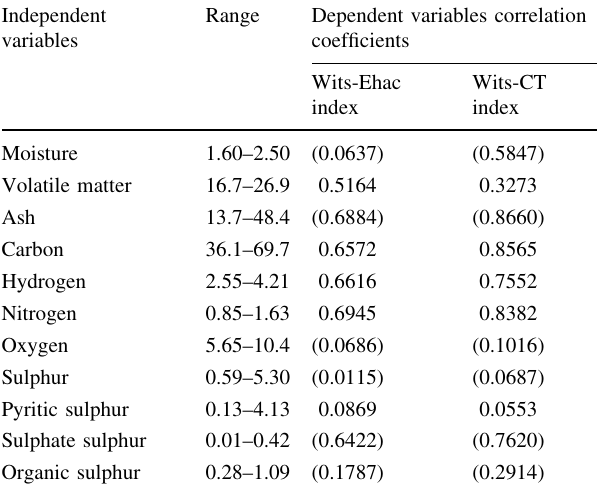
Table 2 Relationships between independent (proximate and ultimate analysis, wt%-ad) and dependent variables for coal samples Independent